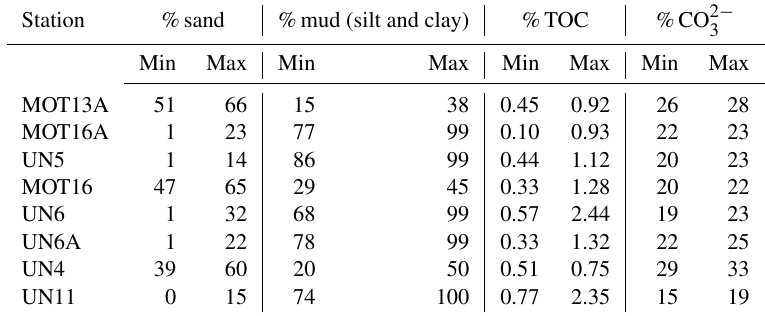
Table 2. Summary statistics of grain size percentages, TOC and carbonate content along the collected cores. Station